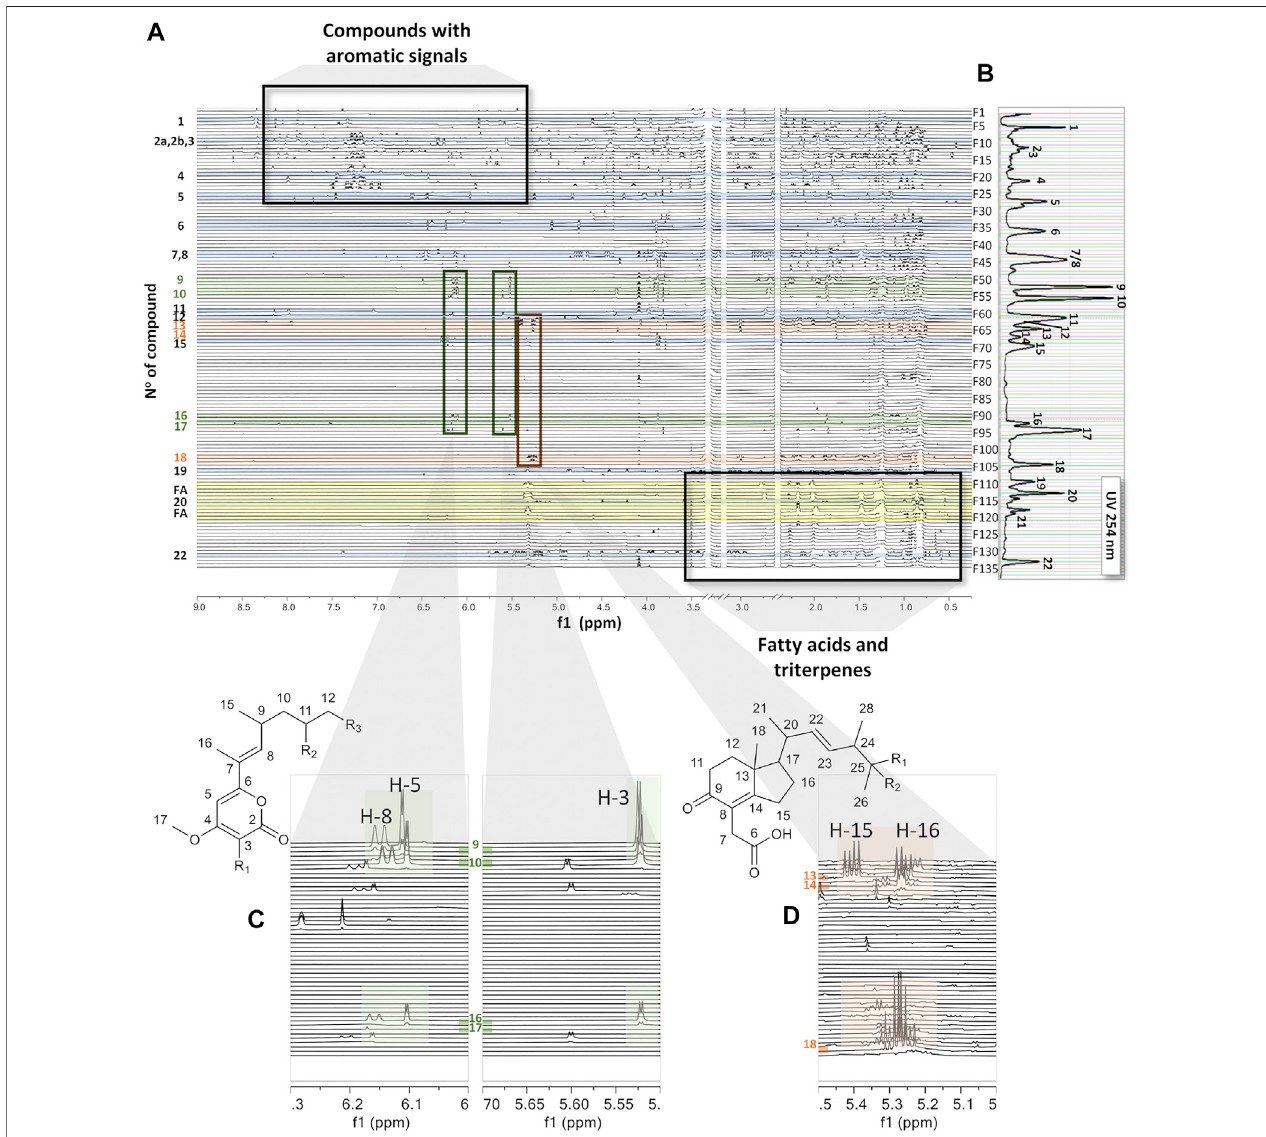
FIGURE 3 | (A) Stacked view of the 1 H-NMR spectra of all fractions ordered by retention time from the top to the bottom, all recorded in DMSO- d 6 as the bridging solvent. The green shadow highlights common signals in fractions F51 – 56 in the regions of δ H 5.5 to 5.7 and δ H 6.0 to 6.3. The orange shadow highlights common signals infractions F64 – F65 and F103 – F104 inthe regionof δ H 5.2to 5.3.The yellow shadow highlightsthe presence offatty acids. (B) UV trace ofthesemi-preparative HPLCchromatogramforLCpeaklocalization( Figure1E ). (C) Insetshowingcharacteristicsignalsoftheseriesacrossasetoffractions,F51 – F56andF90 – F93. (D) Inset showing characteristic signals of the series across a set of fractions, F64 – F65 and F103 – F104.